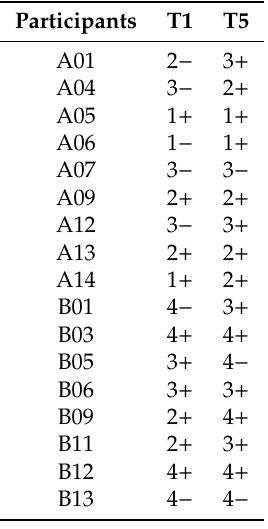
Table 4. Listening performance scores on the first (T1) and last (T5) training